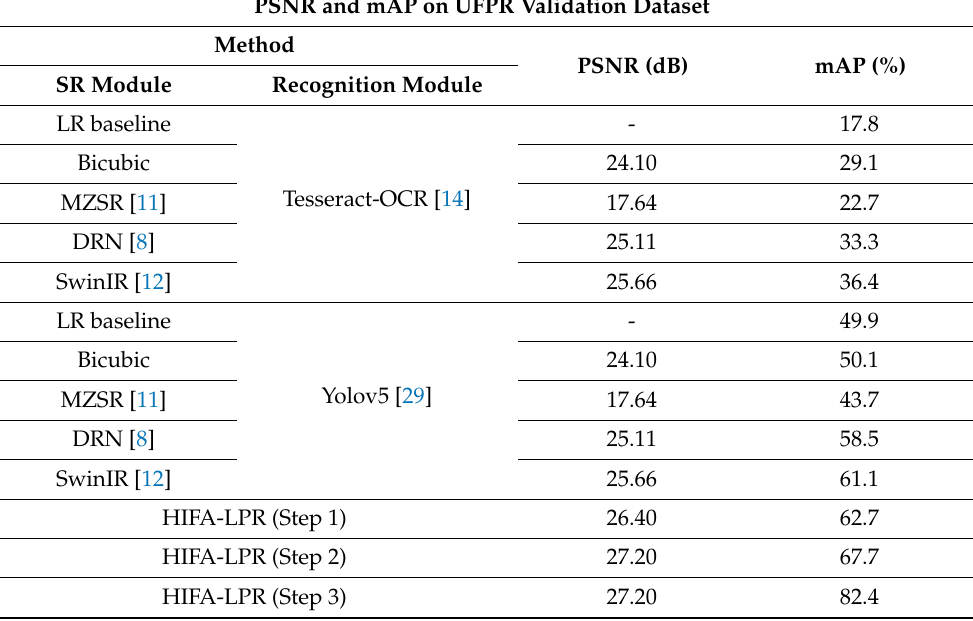
Table 1. Comparison between the HIFA-LPR model and other existing approaches for scale factor ( × 3) on the UFPR dataset.